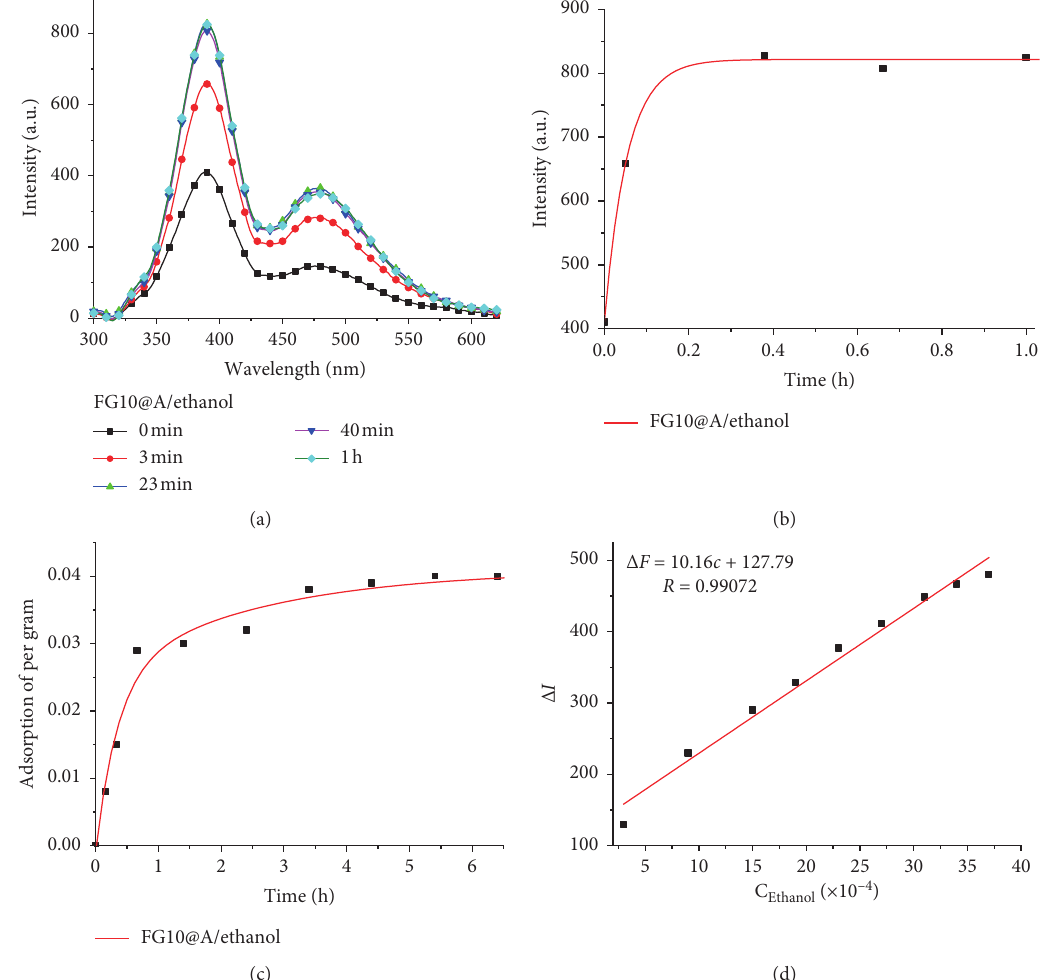
Figure 5: (a) Titration fluorescence spectra of the loading of FG 10@ A with ethanol; (b) change in fluorescence intensity of FG 10@ A with increasing adsorption time; (c) adsorption profile of the loading of ethanol in FG 10@ A ; (d) plot of Δ I vs . the amount of ethanol adsorbed by solid FG 10@ A